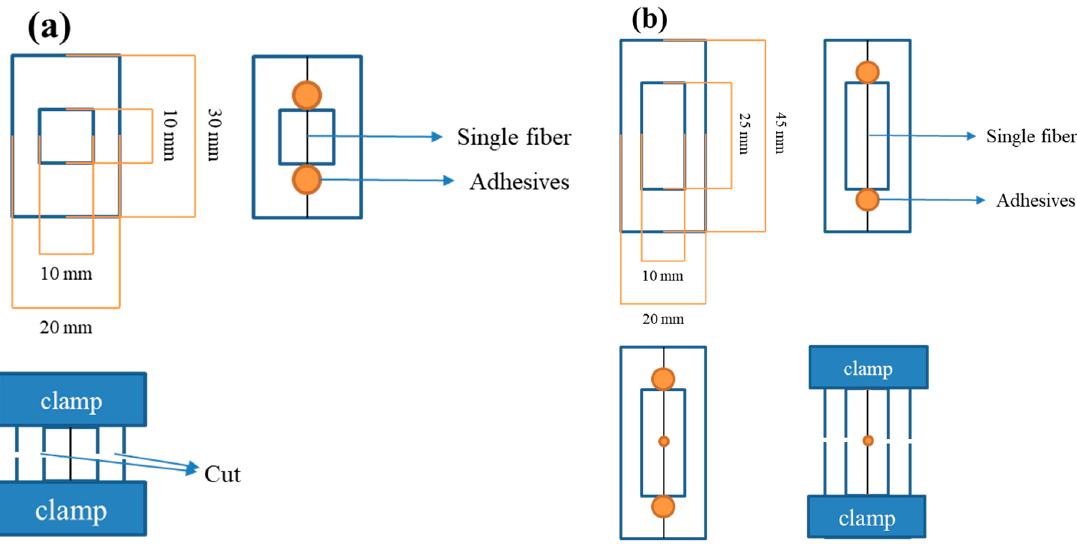
Figure 3. Schematics of physical properties test; ( a ) tensile strength and ( b ) interfacial shear strength.